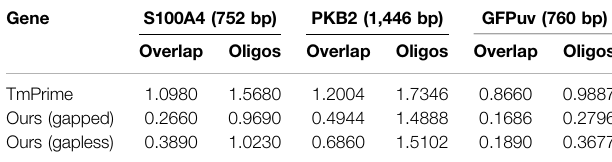
TABLE 4 | Compared to the three genes designed by TmPrime, the oligonucleotide set designed by our algorithm possesses the least SD of overlap and oligonucleotides in Tm value (all the oligonucleotides were designed under the same